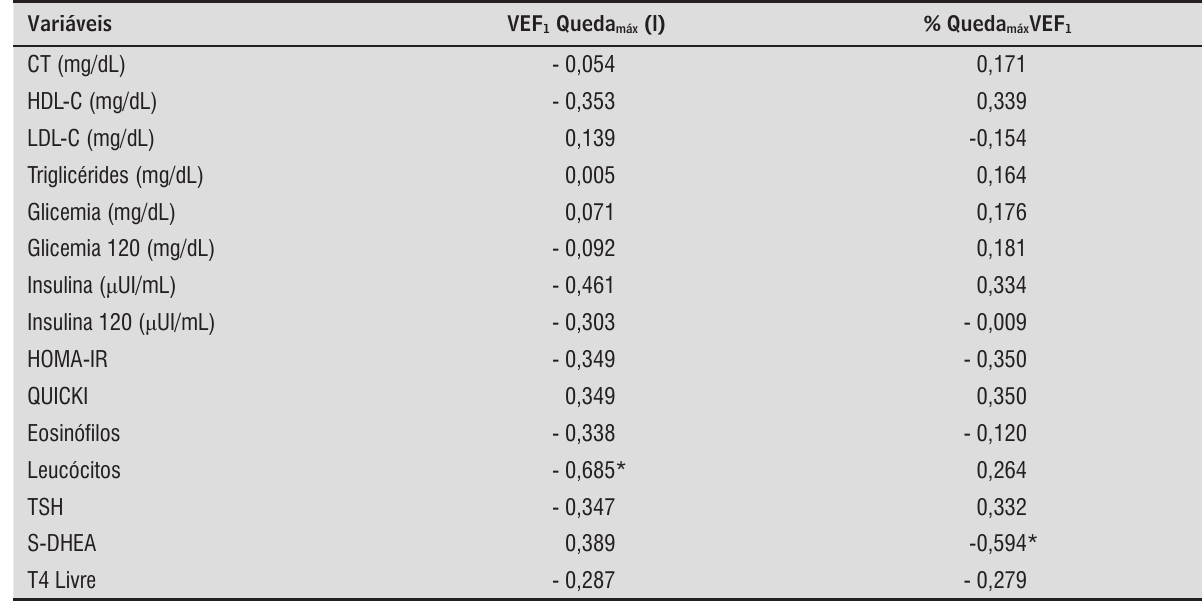
Tabela 5 - Correlações entre as variáveis espirométricas após teste de broncoprovocação por solução salina e os parâme- tros